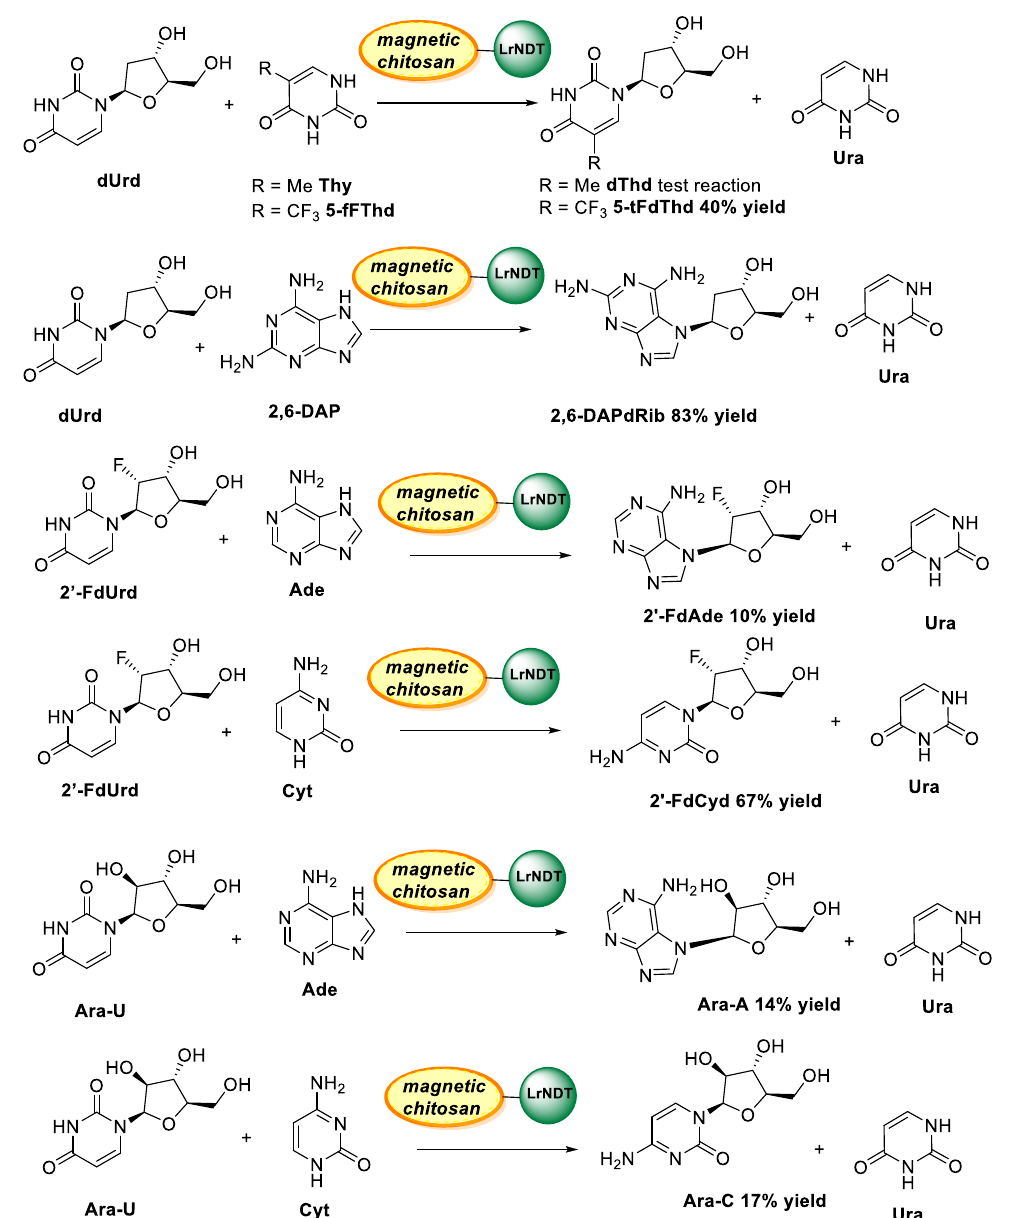
Figure 8. Synthesis of different natural and non- natural nucleosides using a recombinant nucleoside 2’ -deoxyribosyltrans- ferase from Lactobacillus reuteri (LrNDT) immobilized on cross-linked magnetic chitosan beads [165] . Commission on Bi- ochemical Nomenclature: adenine (Ade), uracil (Ura), cytosine (Cyt), thymine (Thy), 2,6-diaminopurine (2,6-DAP), 5-tri- fluorothymine (5- tFThy), 2’ - deoxyuridine (dUrd), 2’ - deoxyadenosine (dAdo), 2’ -deoxycytidine (dCyd), thymidine (dThd), 2,6-diaminopurine- 2’ -deoxyriboside (2,6-DAPdRib), 5-trifluorothymidine (5- tFdThd),2’ -fluoro-20- deoxyuridine (2’ - FdUrd), 2’ -fluoro- 2’ - deoxycitydine (2’ -FdCyd), ara-uracil (ara-U), ara-adenine (ara-A).